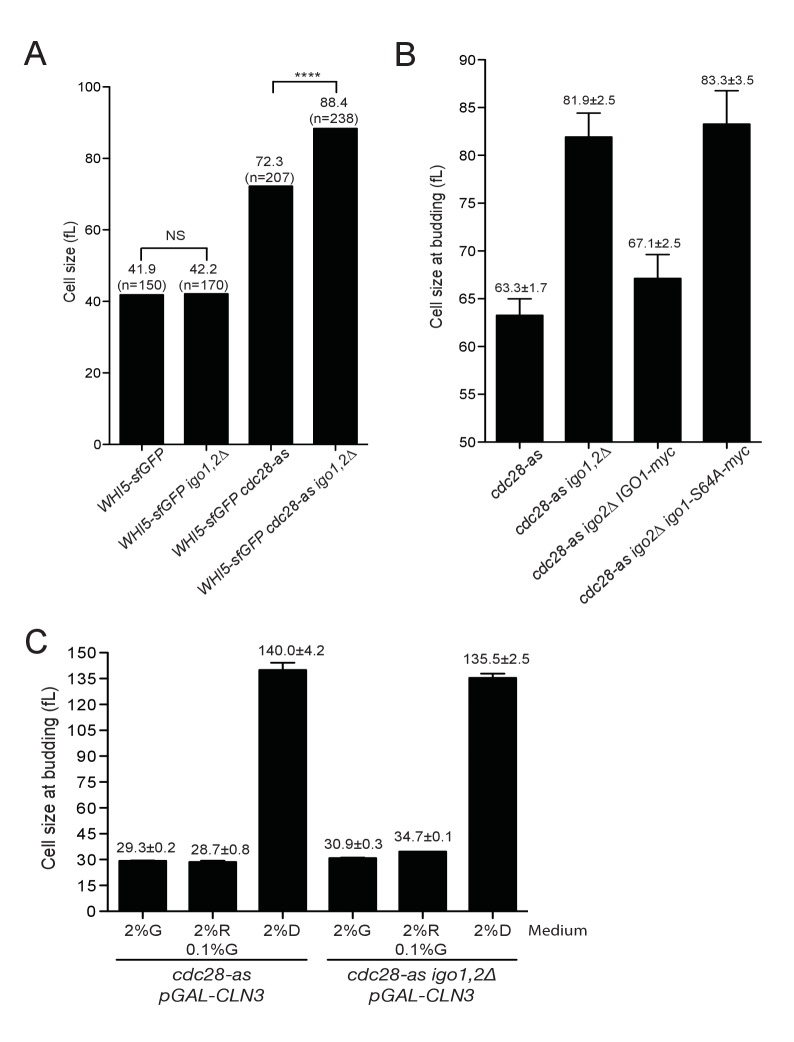
Rim15 and Cln-Cdk1 kinases cooperate to set the cell size at START.(A) Single cell measurements of cell size in G1. Median cell volume of Whi5-positive unbudded cells in asynchronously growing cells of the indicated genotype (E5100, E4948, E5101, E5102), determined with BudJ software. N indicates the number of cells measured in each strain. Mann-Whitney test was used to determine if medians are different (NS, non-significant). (B) Increased cell size at budding in cdc28-as1 igo1,2∆ cells is due to Rim15. Median cell size at budding after elutriation of the indicated strains (E4479, E4458, E4996, E4995) released in SC-D at 30°C. Mean ±SD of two independent experiments. (C) Cell size at budding of cdc28-as1 and cdc28-as1 igo1,2∆ depends on CLN3. Size at budding after elutriation was measured for cdc28-as1 (E4479), cdc28-as1 igo1,2∆ (E4458), cdc28-as1 GAL-CLN3 (E5373) and cdc28-as1 igo1,2∆ GAL-CLN3 (E5231) grown SC-D, SC-Gal or SC-Raf +0.1% Gal. Mean ±SD of two independent experiments.